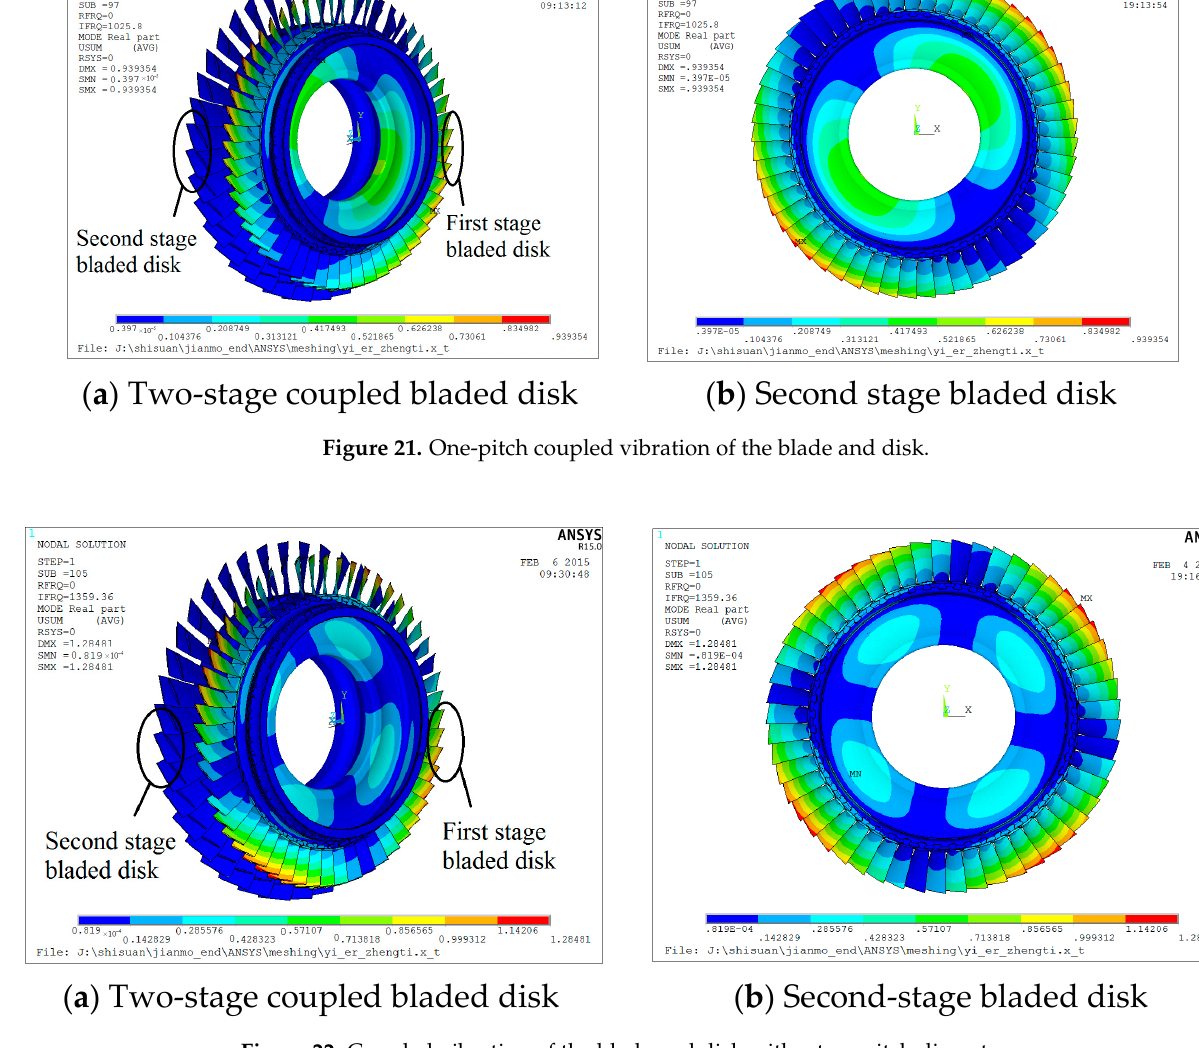
Figure 22. Coupled vibration of the blade and disk with a two-pitch diameter.